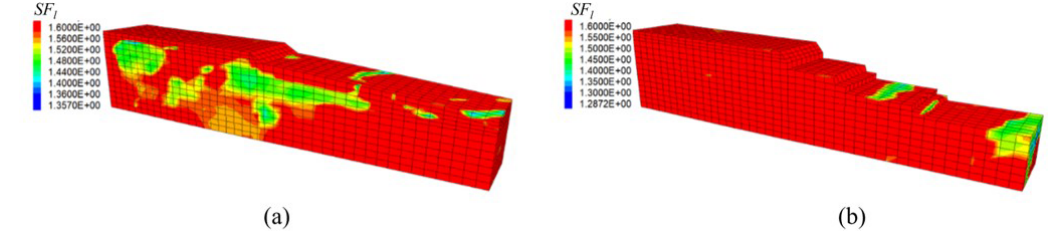
Figure 36. Safety factor versus liquefaction (a) after seismic loading and (b) after tsunami loading.